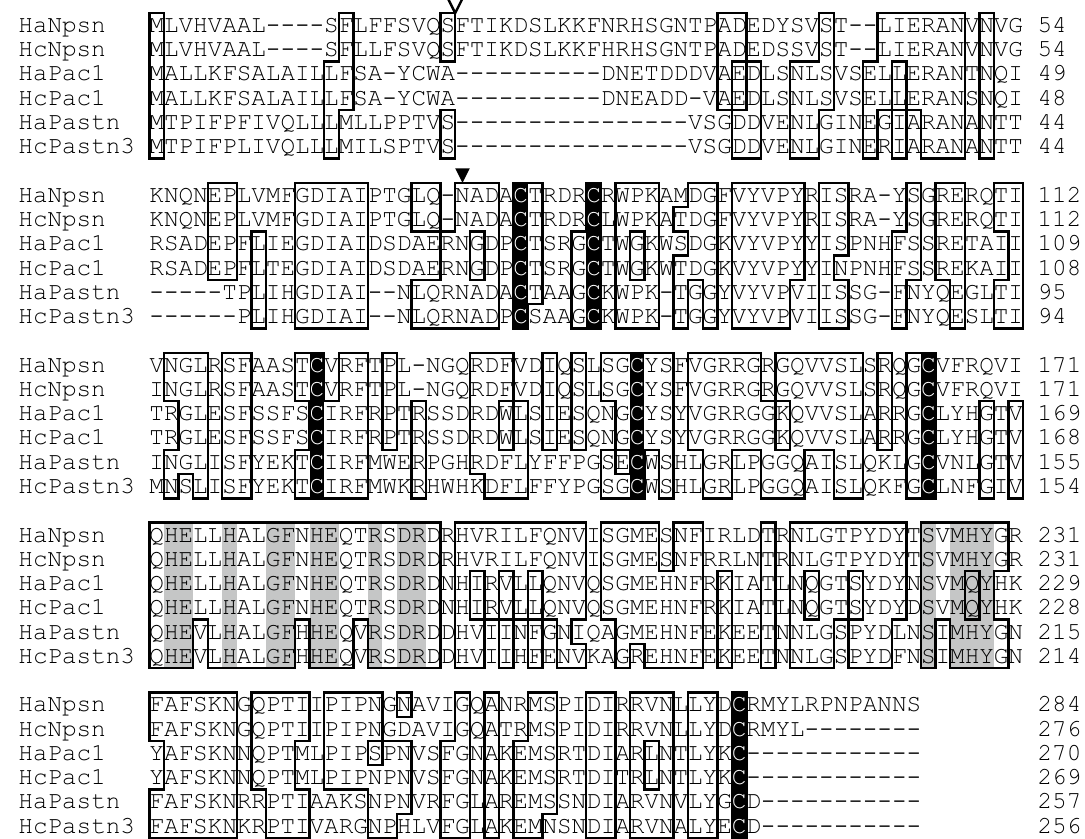
Figure 1. Multiple alignment of amino acid sequences of nephrosin, pactacin and patristacin of pot-bellied seahorse (HaNpsn, HaPac1 and HaPastn) and tiger tail seahorse (HcNpsn, HcPac1 and HcPastn3). Identical residues are boxed. Dashes represent gaps. Two active site consensus sequences of the astacin family proteases (Zn-binding site, HExxHxxGFxHExxRxDR, and methionine turn, SxMHY) are indicated in gray boxes. Conserved cysteine residues are shaded in black. Open and solid triangles indicate putative signal sequence cleavage sites and N-termini of the astacin protease domain,